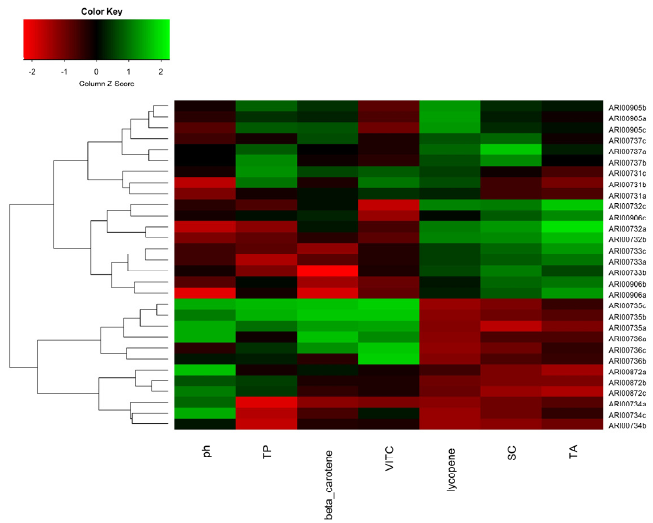
Figure 6. Hierarchical clustering among Cypriot tomato landraces based on phytochemical properties established from three biological replicates.